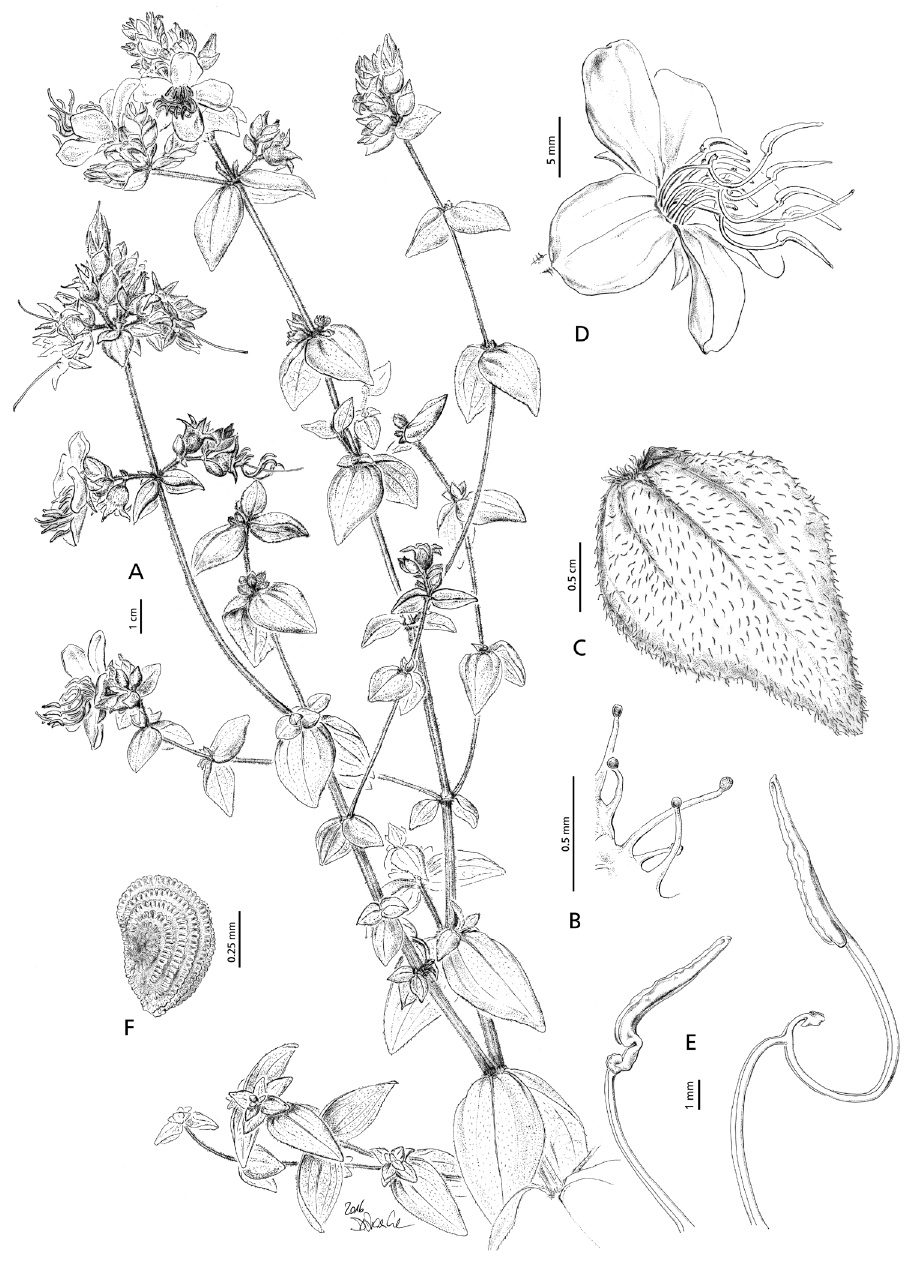
Figure 1. Argyrella richardsiae , A habit B glandular trichomes C leaf D flower E stamens: inner stamen (left), outer stamen (right) F seed (drawn from Mrs H.M. Richards & S. Arasululu 26190 and Bidgood et al. 3935). Illustration by Doris